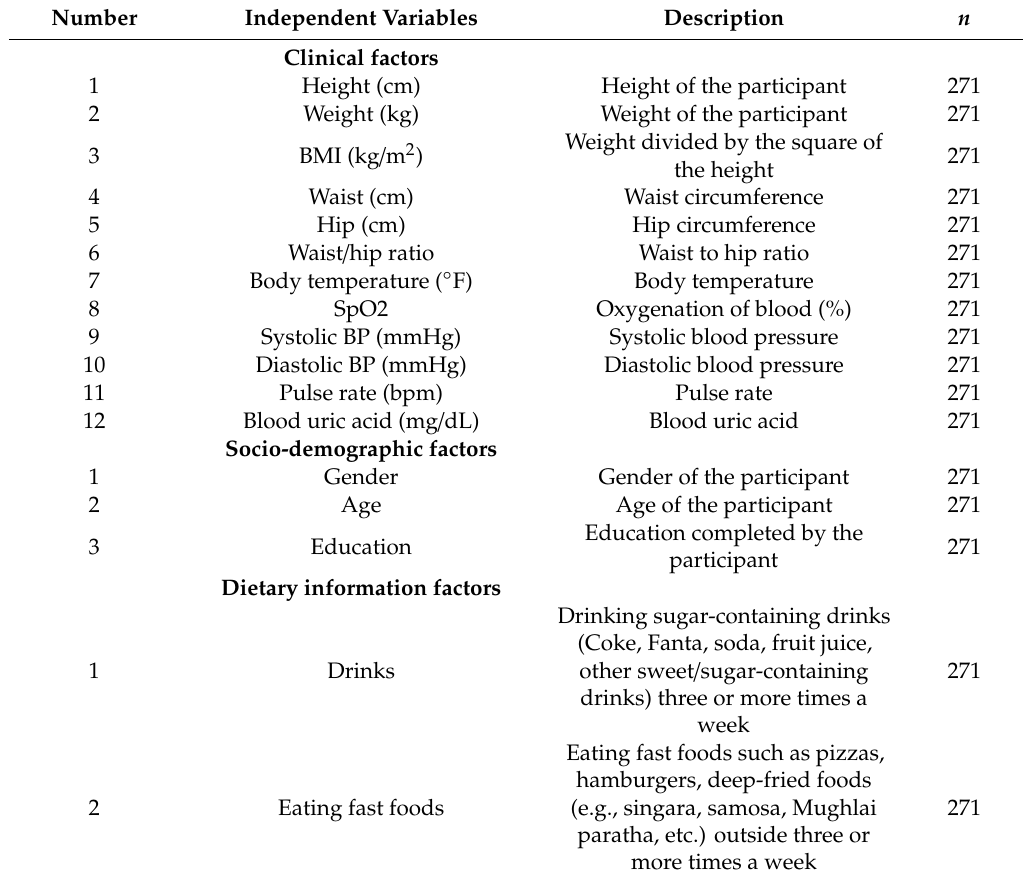
Table 1. Description of independent